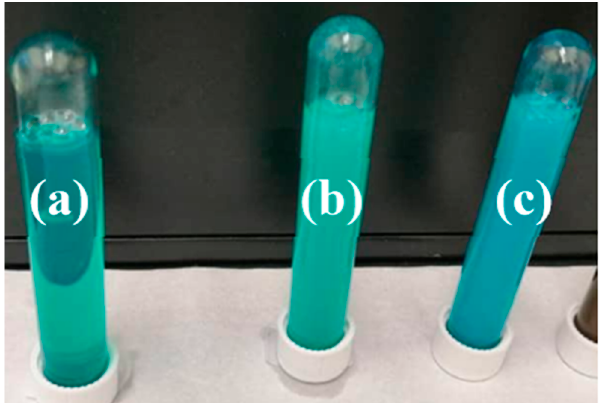
Figure 10. Gel formed by CuAc at room temperature at various pH values: ( a ) No gel at pH = 5.23 and weak gel at ( b ) pH = 7 and ( c ) pH = 11.